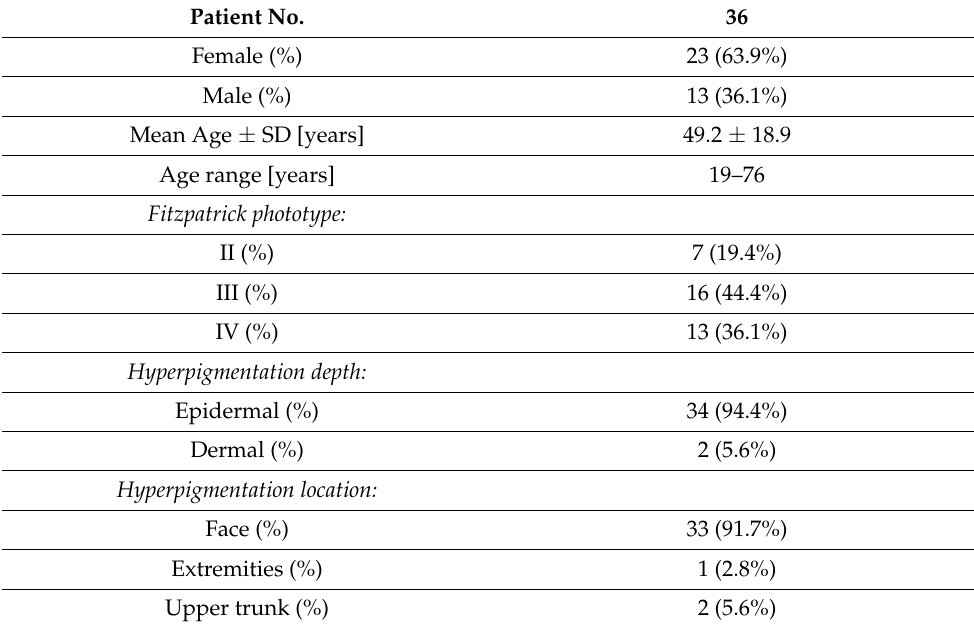
Table 1. Demographic data of included patients.